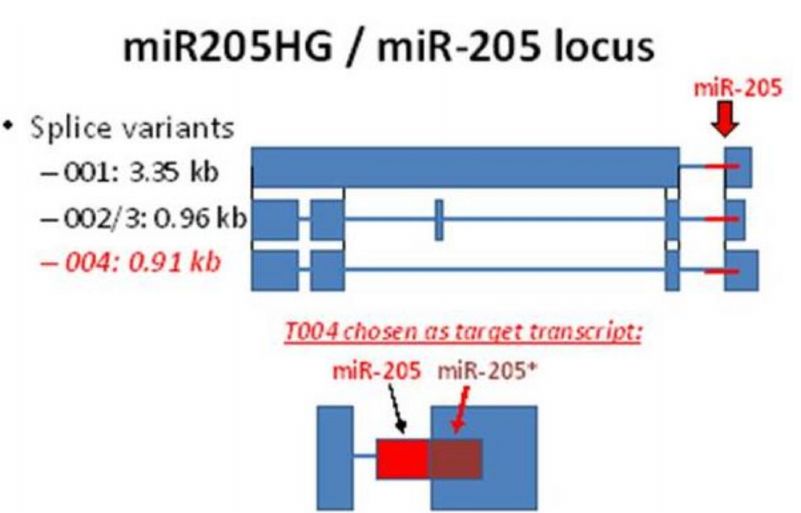
Figure 1. Illustration of miR205HG gene locus with three transcript variants and their corresponding sizes